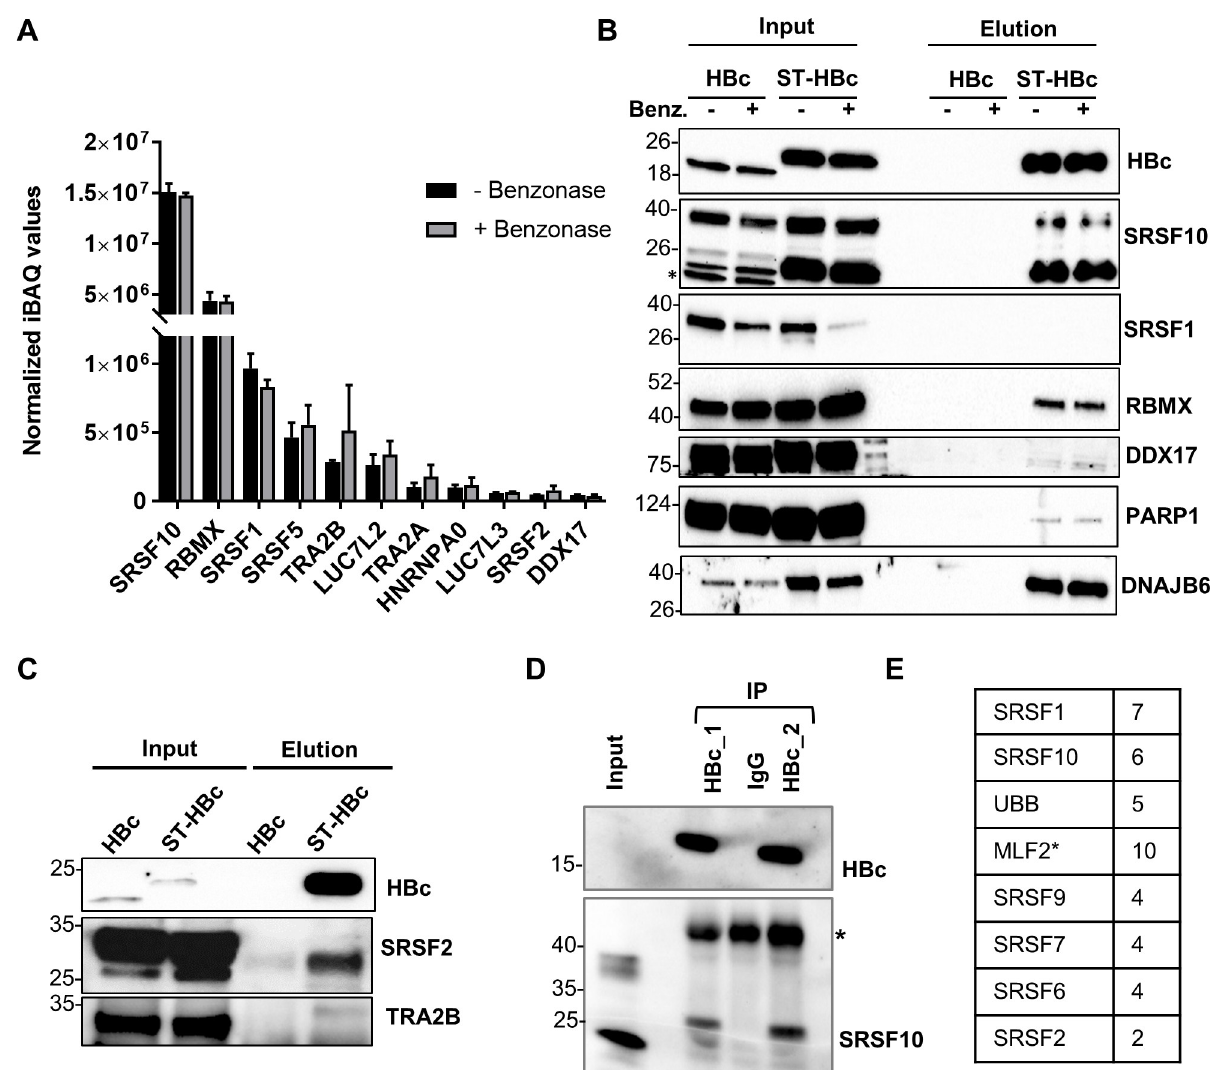
Fig 3. Validation analyses. (A) Relative abundances of the 11”founder” RBPs identified in HBc nuclear complexes submitted or not to Benzonase treatment. The relative abundances of HBc binding partners have been evaluated using the iBAQ metrics [104]. For each replicate, each iBAQ value was normalized by the summed values of the 11 proteins. Error bars represent +/- SD. (B) and (C) Western blot validations in Benzonase treated and streptactin-purified and extracts. Two major isoforms of SRSF10 are visible: the upper at 37KDa and the lower at 20–22 KDa. The band indicated with an asterisk likely corresponds to a band generated by proteolytic cleavage. (D) HBc was immune-precipitated from nuclear extracts purified from liver sections from HBV-infected HuHep mice, using two different anti-HBc antibodies. Eluted proteins were analyzed by western blot using anti HBc and anti-SRSF10 antibodies. The asterisk indicates the positions of IgG heavy chain. (E) Proteins included in the gel band between 35 and 25 KDa were analyzed by MS. The table indicates the list of proteins recovered with the anti-HBc antibody that were also previously found after HBc purification on StrepTactin columns (see Fig 1D). � In the case of MLF, 1 peptide was found in the anti-IgG control IP. The other proteins were found exclusively in the anti-HBc IP.